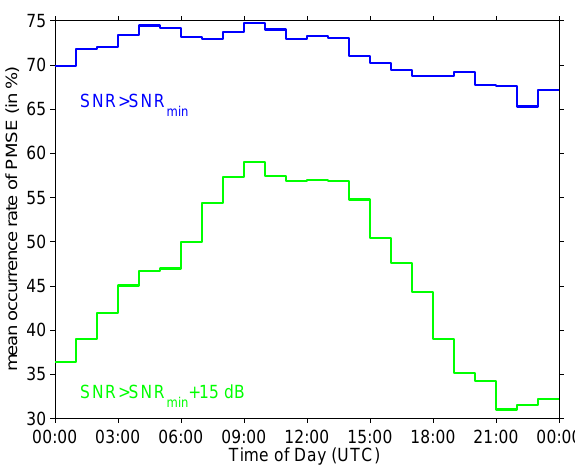
Fig. 7. Colored lines: Mean diurnal variation of PMSE thickness averaged over all PMSE events during five summers between 1999 and 2004 for the periods May/August (red), June/July (green) and the complete summer season (blue). The mean K-index for geomag- netic activity at Longyearbyen (averaged over the complete summer seasons of five years) shows the same diurnal variation (black